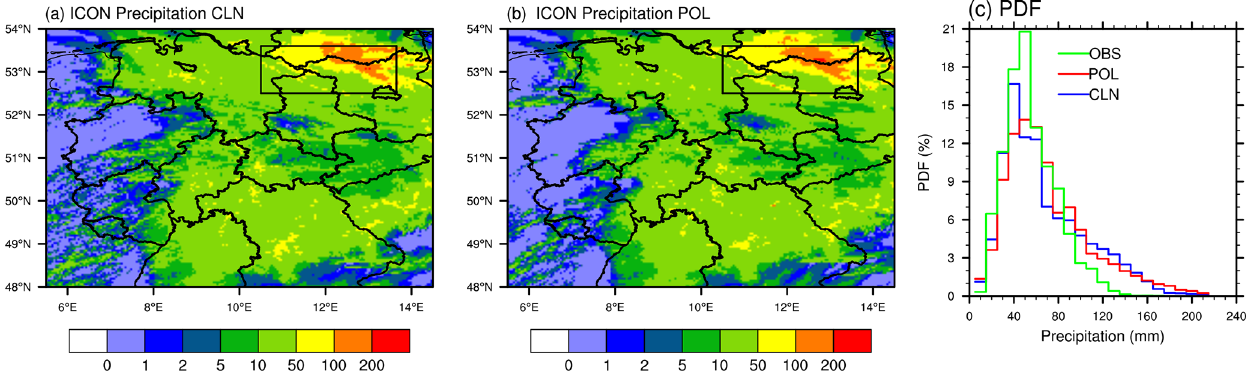
Figure 13. Results from the 635m ICON simulations. Distribution of precipitation (mmd − 1 ) from (a) the factual CLN simulation and (b) the counterfactual POL simulation. (c) PDF of precipitation intensities in the region of interest denoted by the rectangle in (a) and (b) , for the factual (CLN) and polluted (POL) simulations and the observations (OBS) from the RADKLIM precipitation observations.